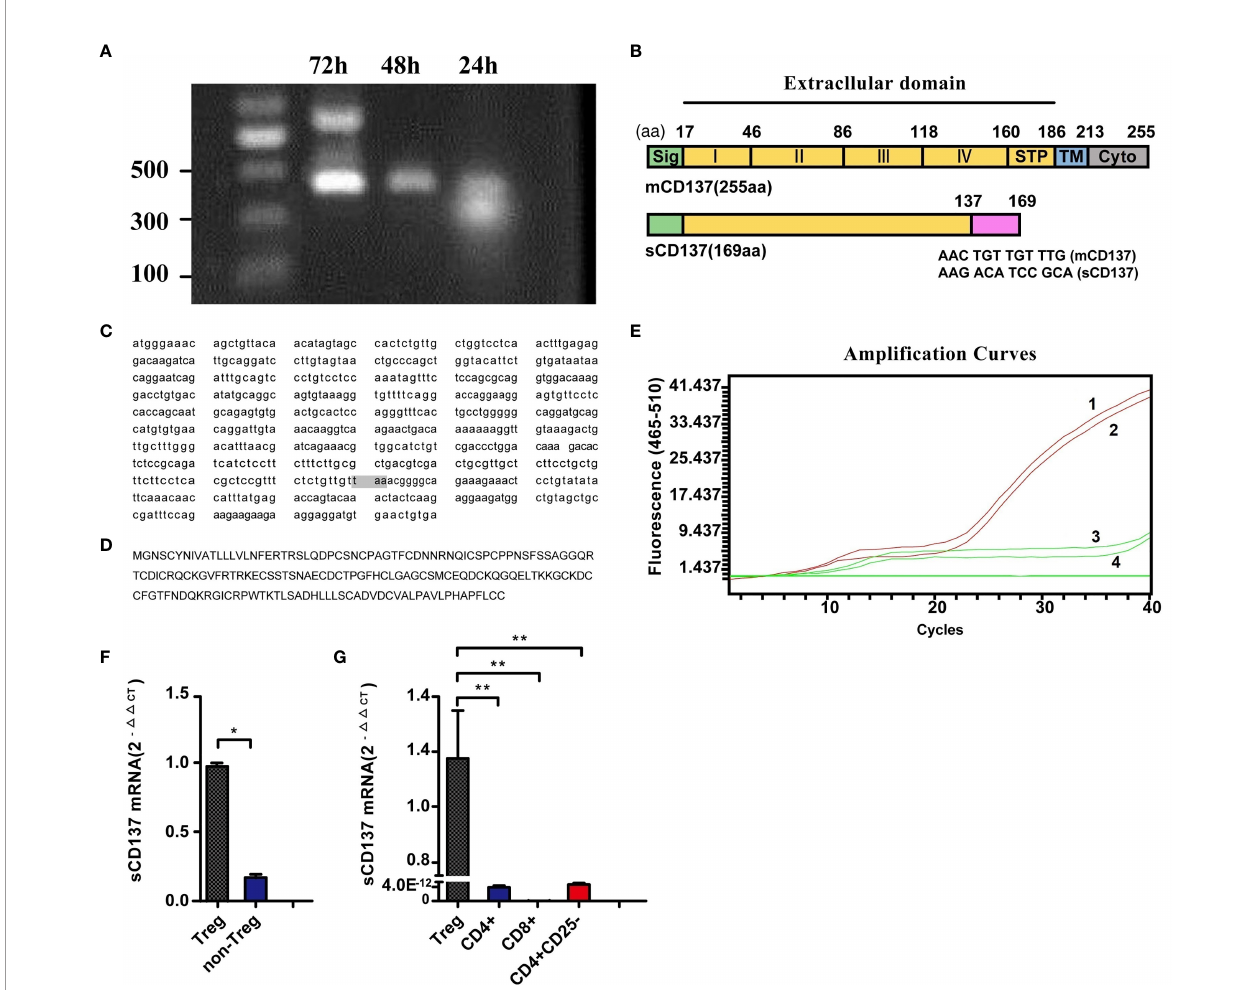
FIGURE 2 | Cloning of sCD137 and constitutive sCD137 expression in Tregs. (A) Ampli fi cation of mCD137 and sCD137 from activated PBMCs by RT – PCR. (B) Alignment of sCD137 to full-length mCD137. The deletion in sCD137 is indicated at the amino acid level, and the codon changes caused by the deletion are shown at the splice point. STP, region rich in the amino acids serine, threonine and proline. (C) The whole sequence of sCD137. The shaded “ taa ” codon is the stop codon. (D) The predicted amino acid sequence of sCD137. (E) Identi fi cation of speci fi c primers and probes for amplifying and detecting sCD137 by ARMS-QPCR. Only sCD137 was ampli fi ed. Ampli fi cation curves 1 and 2 are for T-easy-sCD137, and ampli fi cation curves 3 and 4 are for T-easy-mCD137. (F) sCD137 mRNA comparison of non-Tregs and Tregs. (G) , sCD137 expression in unstimulated Tregs, CD4+ T cells, CD8+ T cells and CD4+CD25- T cells. *P< 0.05, **P<